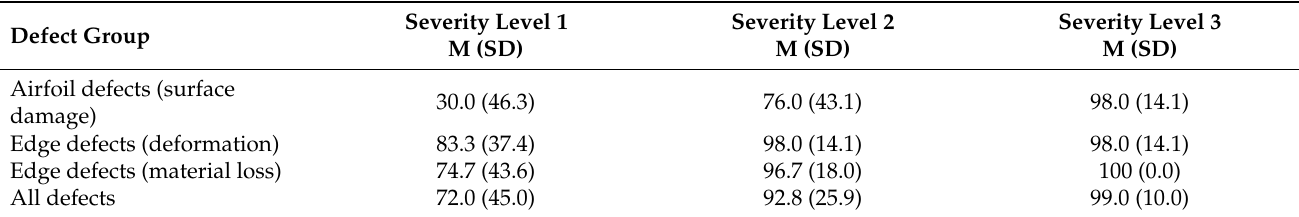
Table 4. Inspection accuracies by defect group and severity level (in